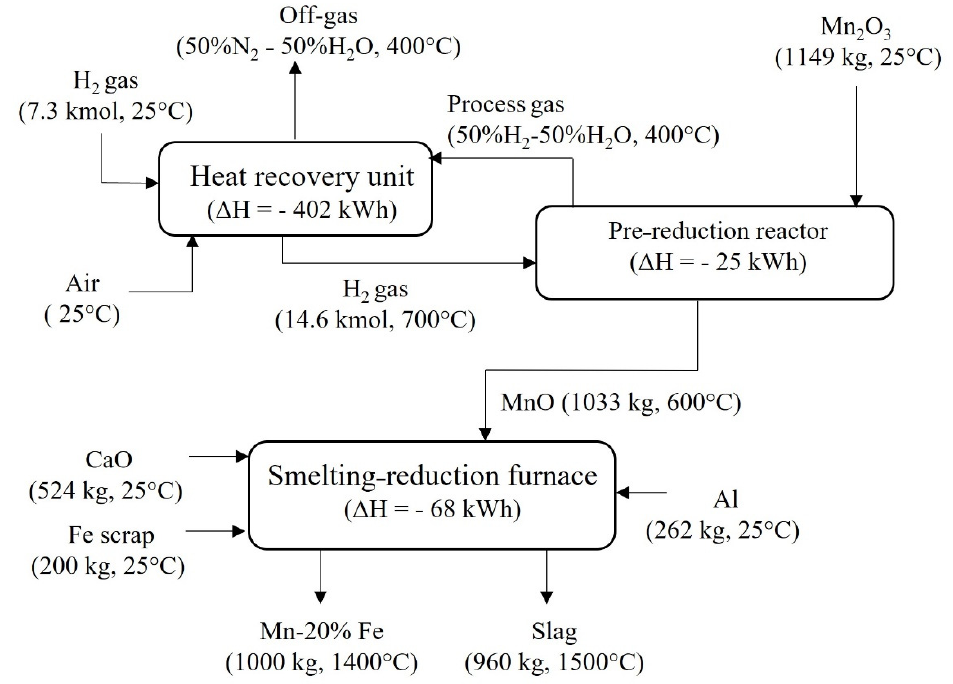
Figure 10. Mass and energy balances for the different units of HAlMan process for Green FeMn production via process illustrated in Figure 6a.